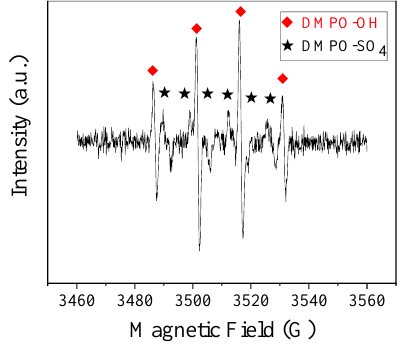
Figure 7. Influences of the different quenchers on PMS oxidation in PBSA degradation. Conditions: [PBSA] = 5 mg L −1 ; [catalyst] = 50 mg L −1 ; [PMS] = 250 mg L −1 ; T = 25 °C; [TBA] (or [EtOH])/[PMS] = 1000:1; and without pH adjustment.